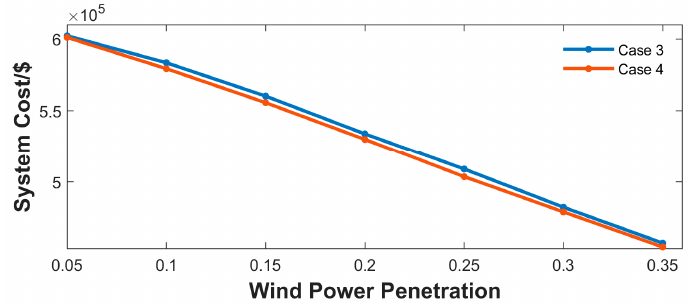
Figure 11. System cost with different wind power penetration.